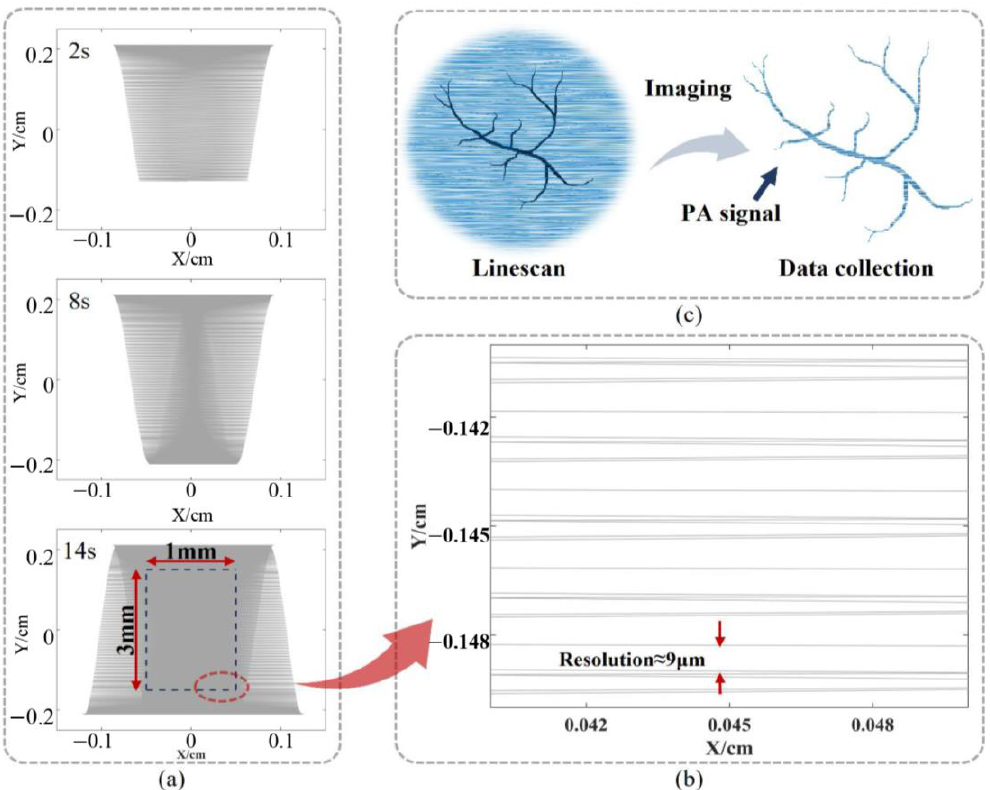
Figure 10. The imaging simulation of “ O ” type. ( a ) The scan state changes over time and results in an effective imaging area of 1 mm × 3 mm at 14 s. ( b ) The edge area of the effective imaging area, indicating the resolution of the image is better than 9 μm. ( c ) The image simulation of a blood vessel sample.